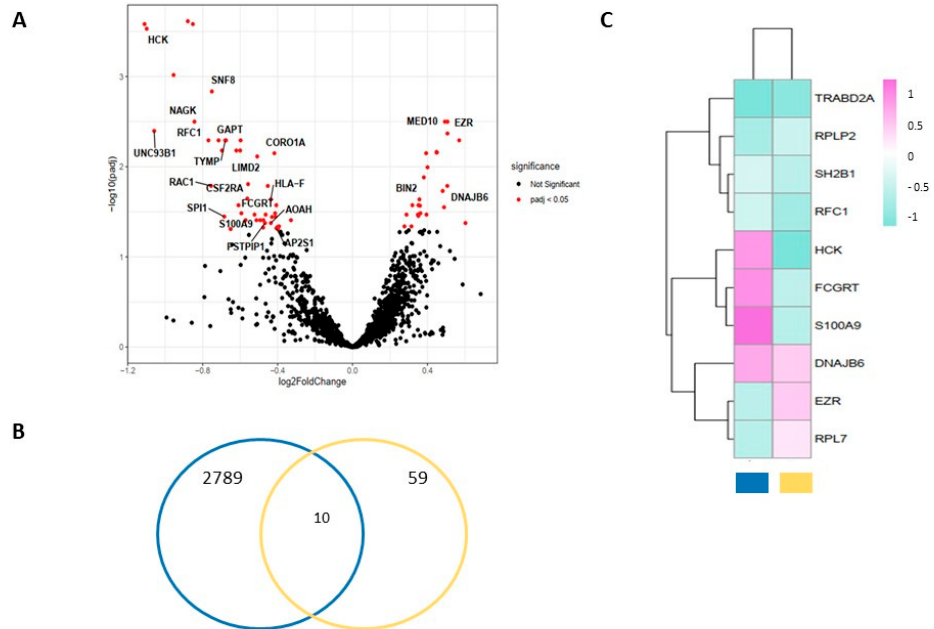
Figure 4. RNA-sequencing profiles analysis of peripheral blood mononuclear cells (PBMC) collected before (D0) and 3 months (M3) after belatacept withdrawal. ( A ) Volcano plot representing the Differential Expressed Genes (downregulated as negative fold change and upregulated as positive fold change) between D0 and M3; ( B ) Venn diagram displaying the relationship of DEGs between D0 and M3 in our dataset (yellow circle) and those associated with subclinical rejection in a previously published RNAseq dataset performed on whole blood collected from 88 KT recipients at the time of 3-month surveillance biopsy [24] (blue circle); ( C ) Heatmap displaying the regulation of the 10 DEGs that overlapped in both datasets. Blue square corresponds to DEGs between D0 and M3, and yellow square to DEGs between subclinical rejection or not on 3 months protocolar biopsy. The positive value/violet color scale represents upregulated genes, whereas the negative value/cyan color scale represents downregulated genes.